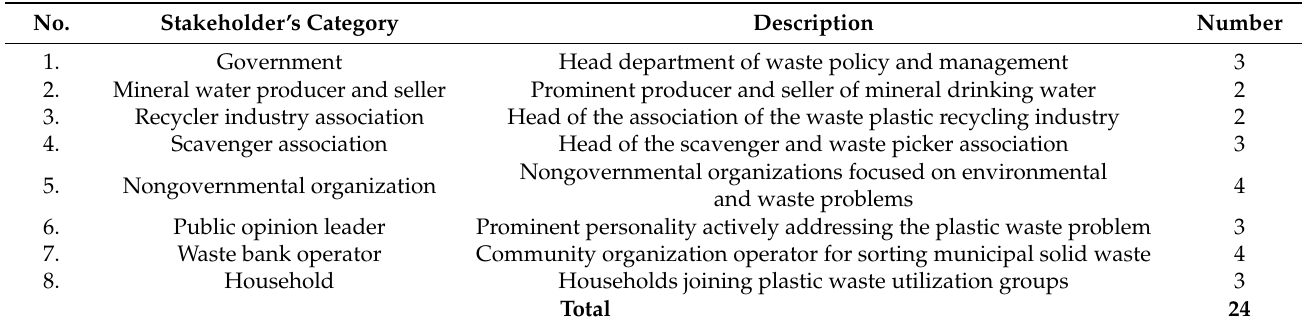
Table 4. Stakeholders’ categories.